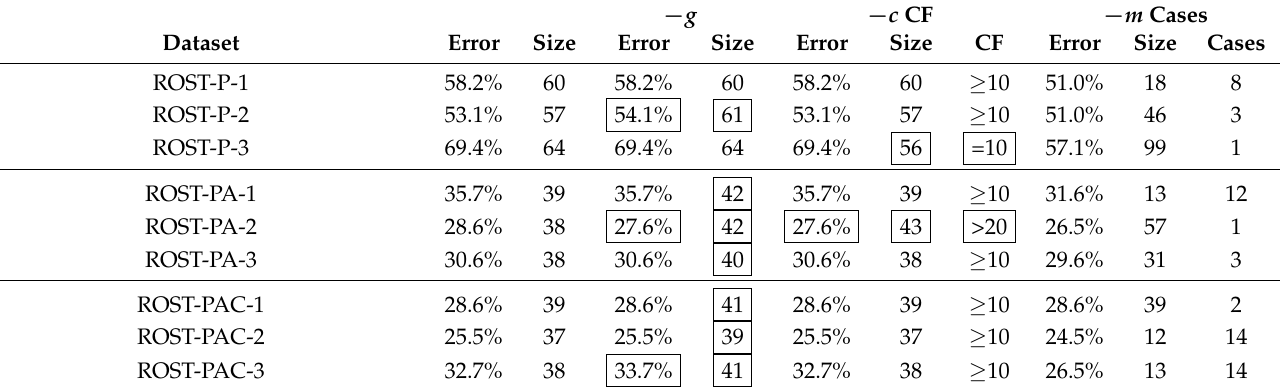
Table A5. Decision tree results on the considered datasets. The number of incorrectly classified data is given as a percentage. Result sets are grouped into columns of Error , Size , and sometimes a parameter. The first set of Error , Size columns represent the results obtained with no options. − g stands for global tree pruning is disabled, − c CF stands for setting the confidence level via the CF parameter, and − m cases stands for controlling how the decision tree is built by using the cases parameter. Error stands for the test error rate, Size stands for the size of the decision tree required for that specific solution, CF stands for “confidence level” ( CF ∈ { 10,20, . . . ,100 } ), and cases stands for the threshold for which is decided to have two more that two branches at a specific branching point ( cases ∈ { 1,2, . . . ,30 }